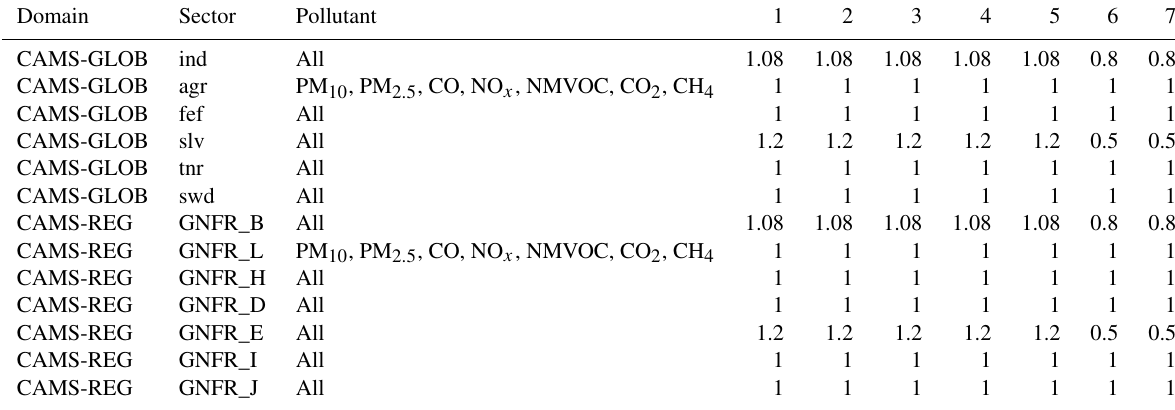
Table A2. Fixed weekly temporal profiles per domain, sector and pollutant. The definition of the sectors can be found in Tables 2 and 3.